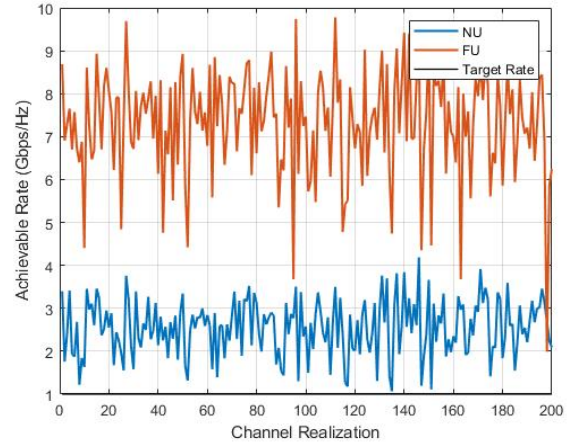
Figure 11. Instantaneous-rate versus channel realization.